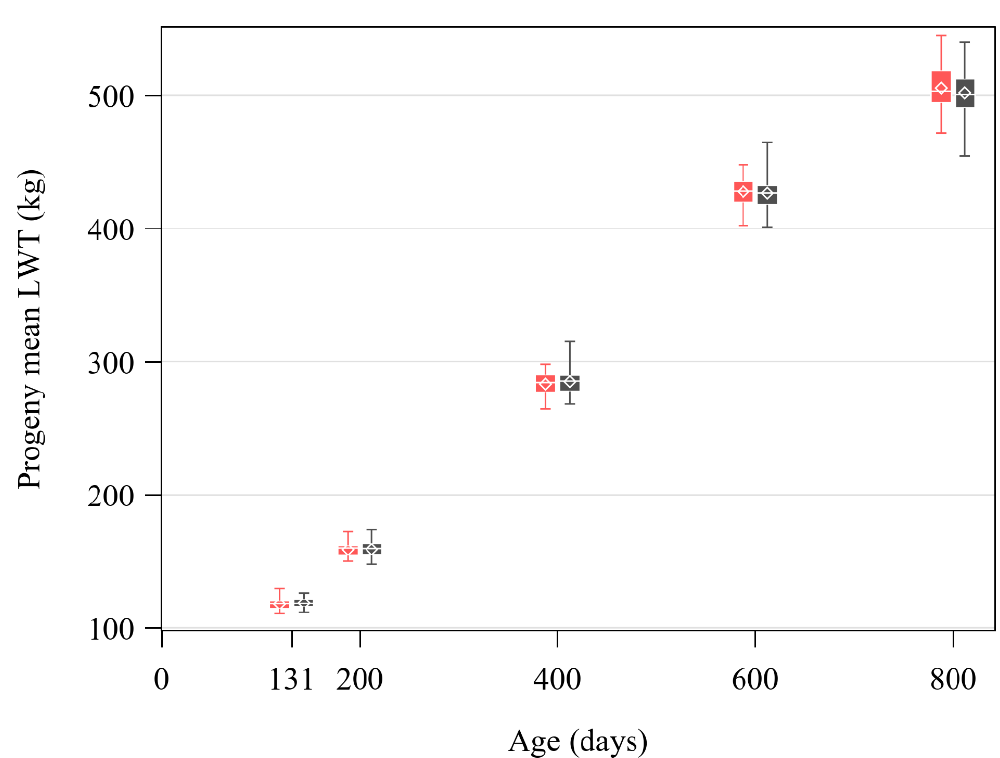
Figure 2. Distribution of least-squares means of the progeny groups of sires (Angus, (cid:4) grey; Hereford, (cid:4) red) for live weight (LWT) at 131, 200, 400, 600 and 800 days of age. Each box represents the inter-quartile range (25th to 75th percentiles), with the median value indicated by a line and the mean value indicated by a marker ( (cid:51) ). Whiskers extend to the minimum and maximum values.